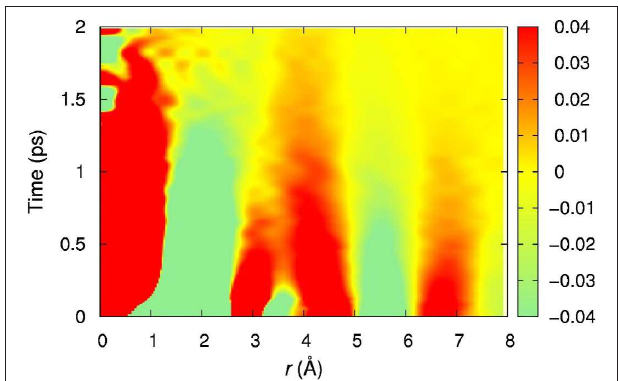
FIGURE 1 | The Van Hove function of water at room temperature determined by inelastic x-ray scattering [3]. The cut at t 0 corresponds to the snapshot = PDF. As time proceeds the nearest neighbors move away, while the second neighbors move in, showing dynamic